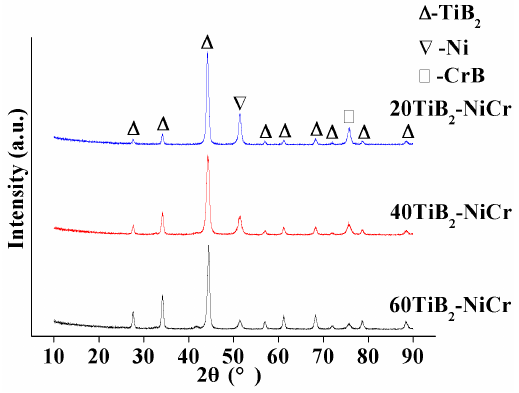
Figure 2. X ‐ ray diffraction (XRD) spectrum of three TiB 2 ‐ NiCr powders. Figure 2. X-ray diffraction (XRD) spectrum of three TiB